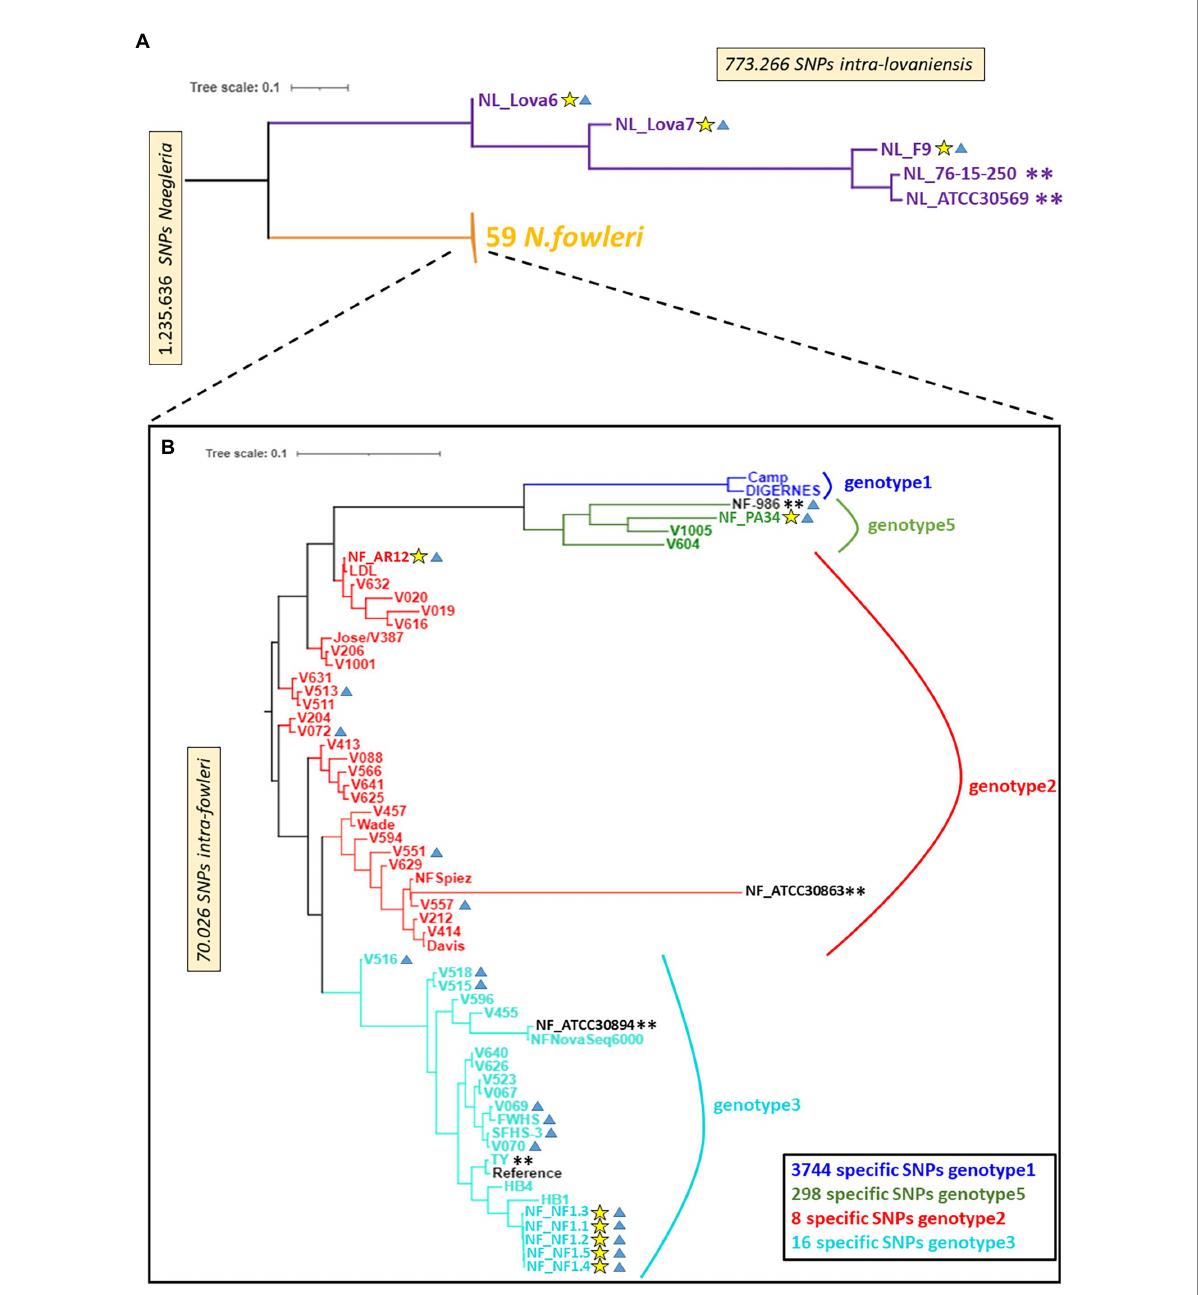
FIGURE 1 A neighbor-joining phylogenomic tree of Naegleria fowleri and Naegleria lovaniensis strains using the whole-genome SNPs. Phylogenomic trees are, respectively, based on 1,235,636 SNPs found in Naegleria genus (A) and 70,026 SNPs found in N. fowleri species (B) . Yellow stars indicate strains sequenced in the present study, blue triangles indicate environmental strains, and double asterisks indicate strains for which a reference genome assembly and annotation were available at the date of writing. Bootstrap support estimates of major ancestral nodes are also